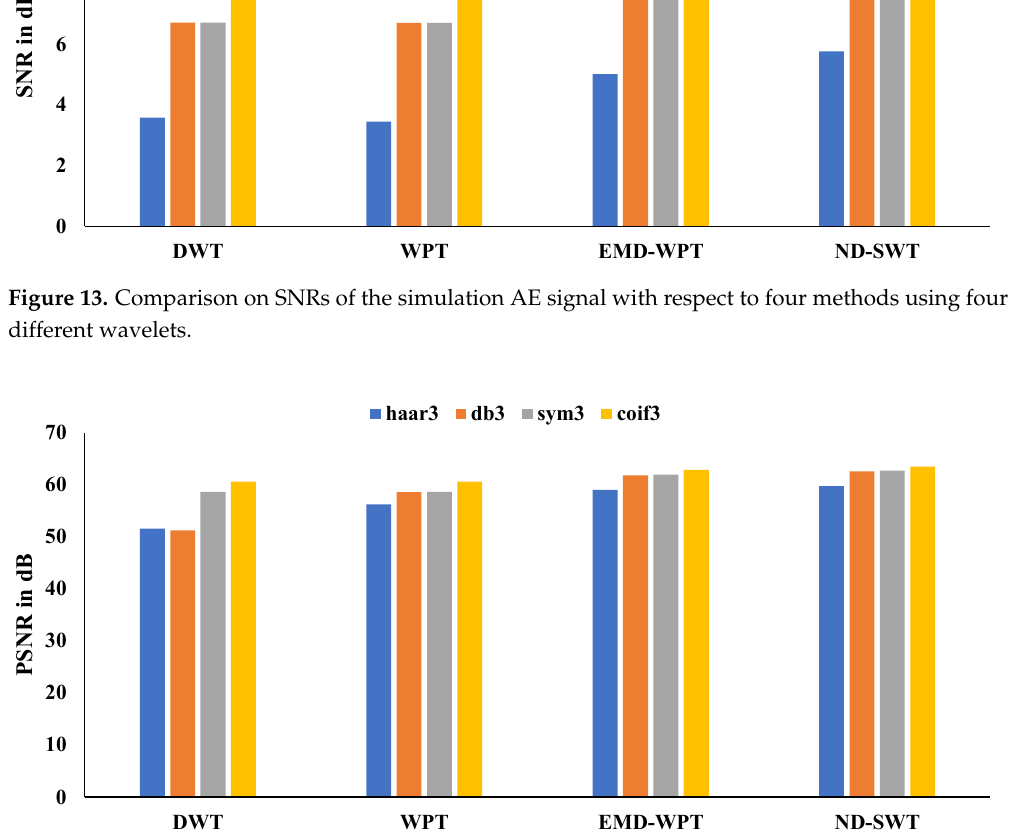
Figure 14. Comparison on PSNRs of the simulation AE signal with respect to four methods using four different wavelets.